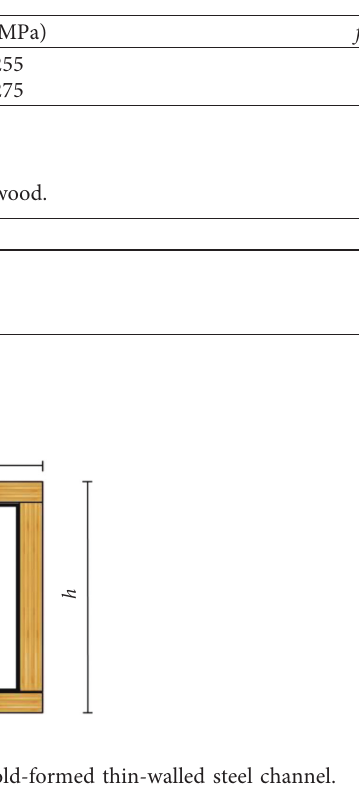
Figure 1: Test of material properties. (a) Test for steel sheet. (b) Test for bamboo plywood. Table 1: Material properties of cold-formed thin-walled steel.